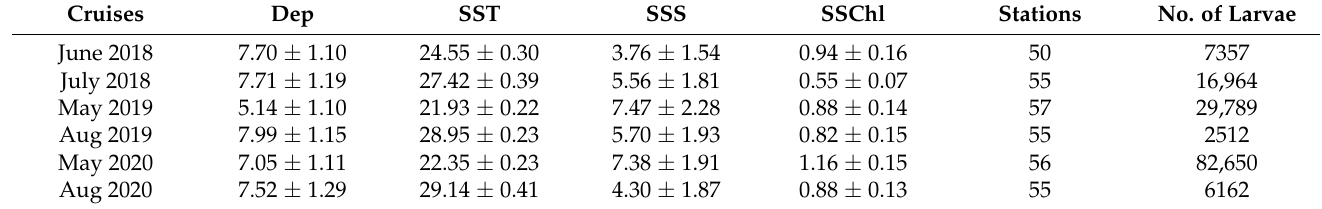
Table 1. Mean values for depth (Dep, m), sea surface temperature (SST, ◦ C), sea surface salinity (SSS), and sea surface chlorophyll a (SSChl, mg/m 3 ) sampled during six cruises in the Yangtze Estuary ( ± 95% confidence interval).